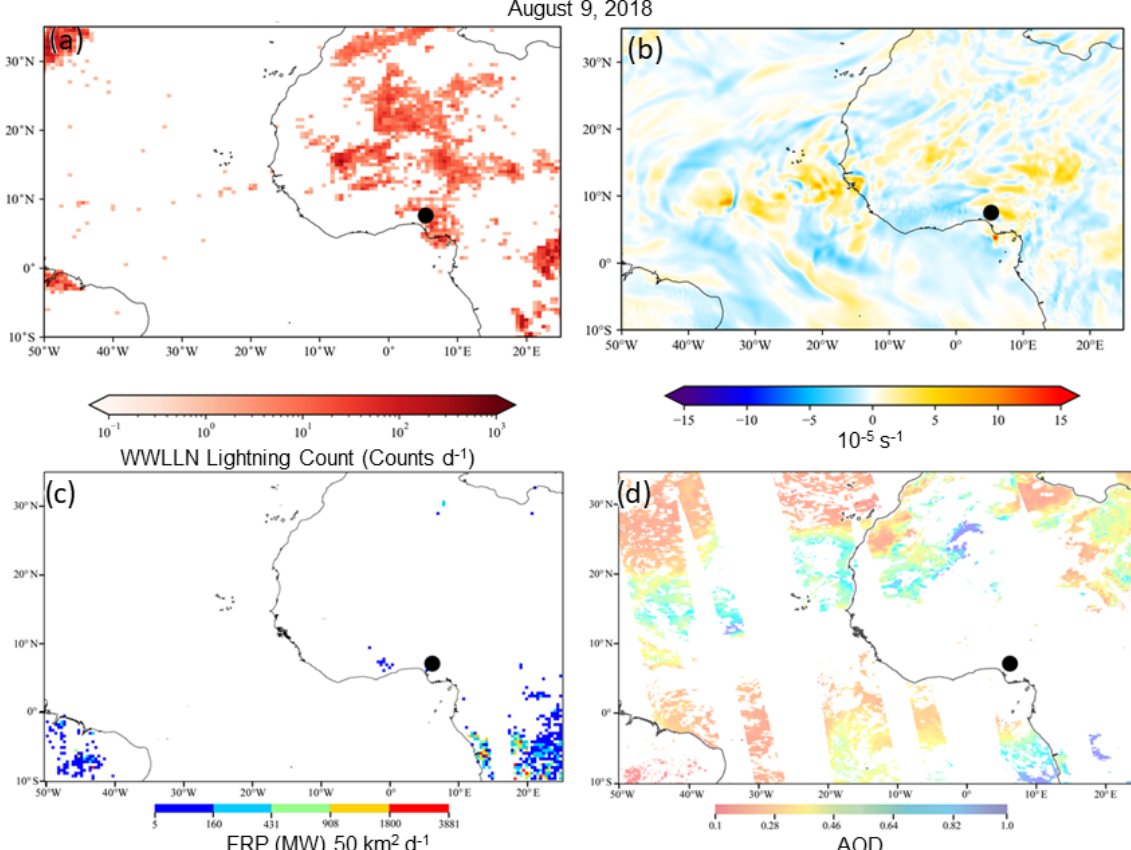
Figure 16. Same as Fig. 13 but for the EIE event recorded on 9 August 2018 (black